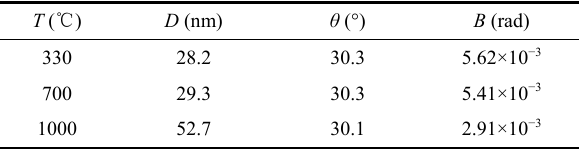
Table 1 θ and B of t(101) XRD peaks measured at different T and